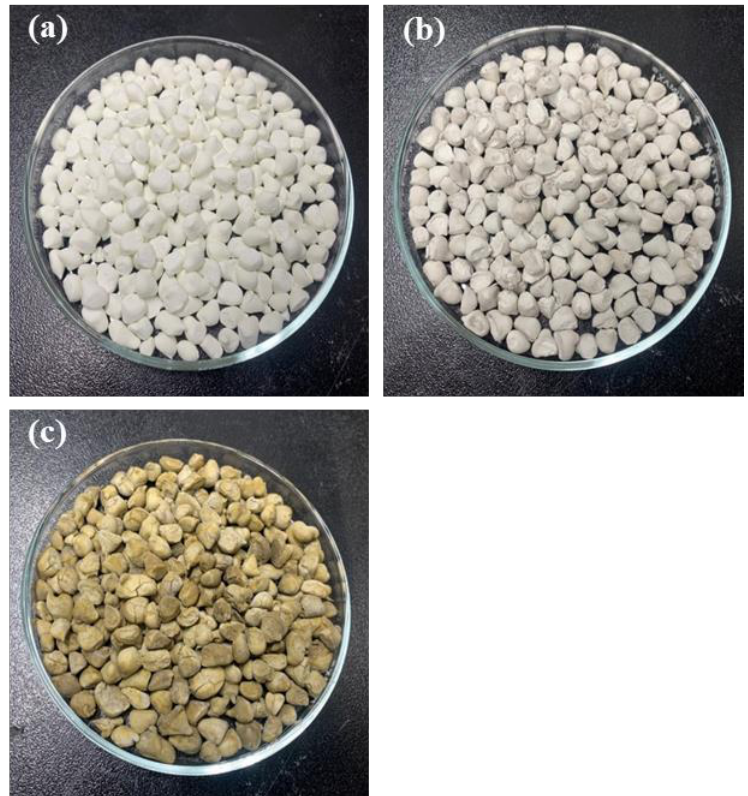
Figure 10. Images of phosphor beads ( a ) Sr 4 Al 14 O 25 :Eu 2+ ,Dy 3+ , ( b ) TiO 2 /Sr 4 Al 14 O 25 :Eu 2+ ,Dy 3+ , and ( c ) Ag-TiO 2 /Sr 4 Al 14 O 25 :Eu 2+ ,Dy 3+ .